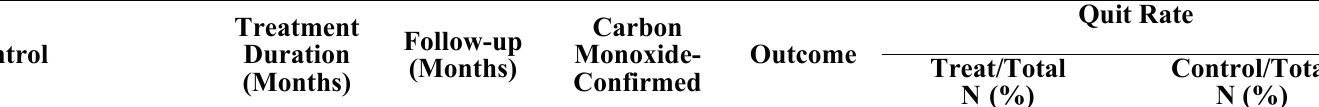
Table 2. Outcome data of the included